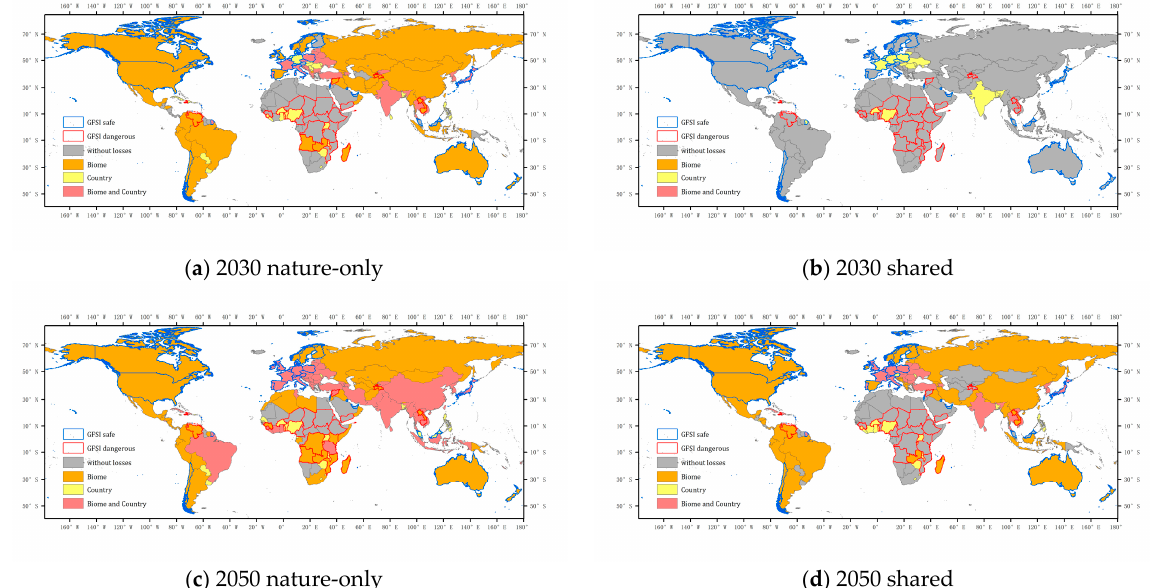
Figure 8. Countries’ conditions of fulfilling Half-Earth plan under different scales. Countries with GFSI in the top 25% are identified as GFSI safe and bordered with blue. Countries with GFSI in the bottom 25% are identified as GFSI dangerous and bordered with red. Countries filled with gray are free of cropland losses at all three scales. Orange, yellow and pink represent the scale, at which countries have to abandon cropland. Antarctica and Greenland are not included on the map.